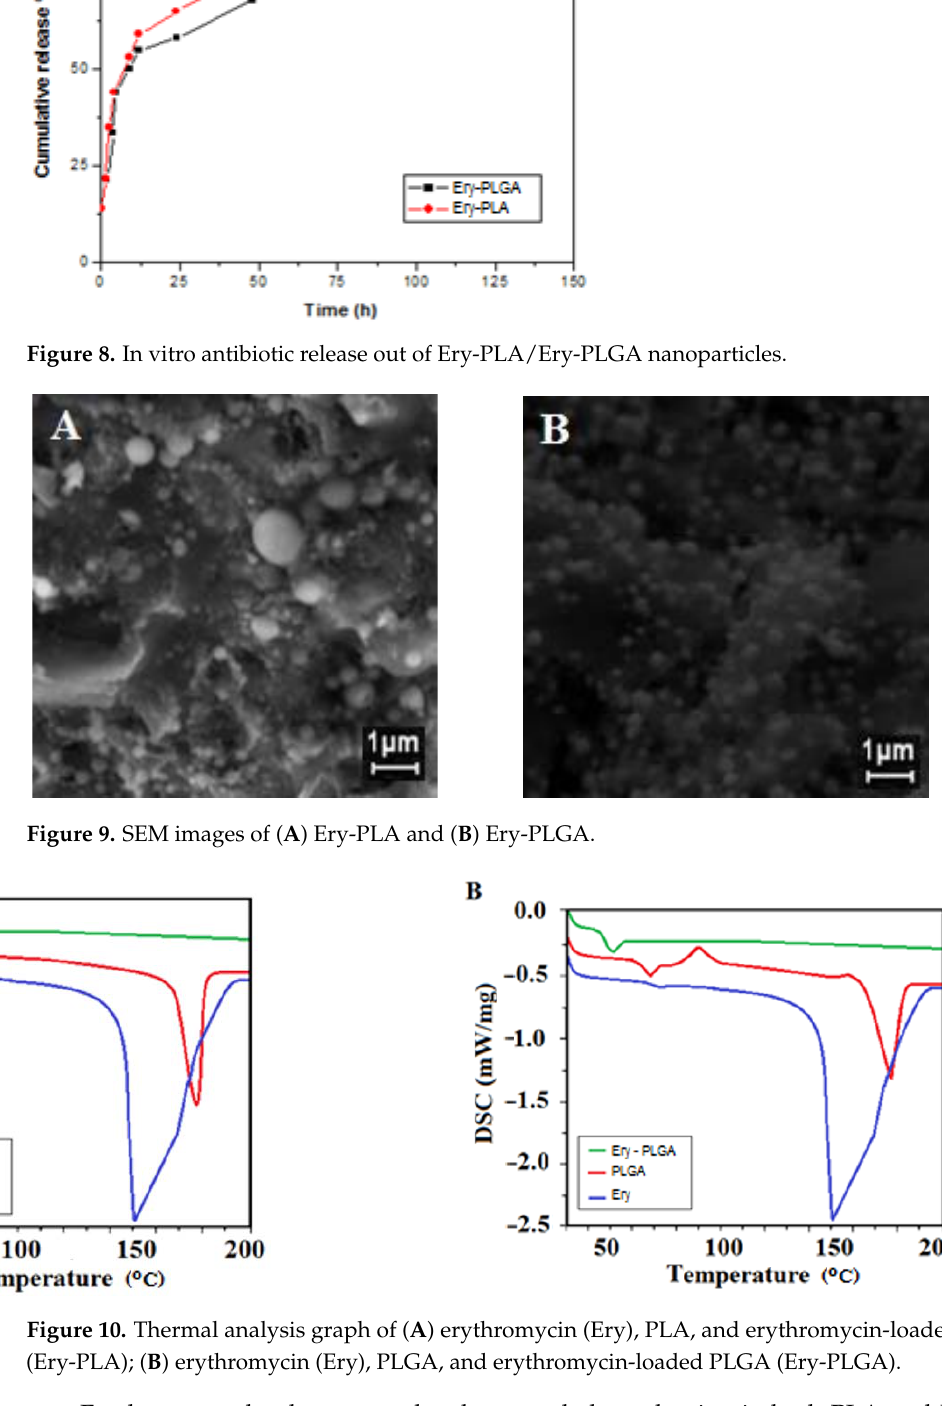
Figure 10. Thermal analysis graph of ( A ) erythromycin (Ery), PLA, and erythromycin ‐ loaded PLA (Ery ‐ PLA); ( B ) erythromycin (Ery), PLGA, and erythromycin ‐ loaded PLGA (Ery ‐